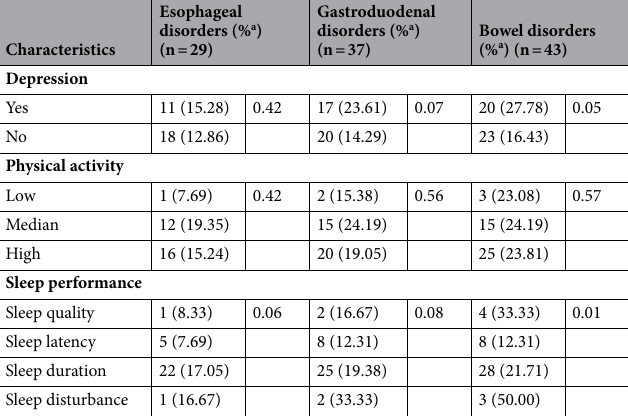
Table 6. Factors associated with functional gastrointestinal disorders. a The prevalence of the sub-type FGID in the corresponding classification. P values were based on χ 2 test between the sub-type FGID group and no-FGOD group.